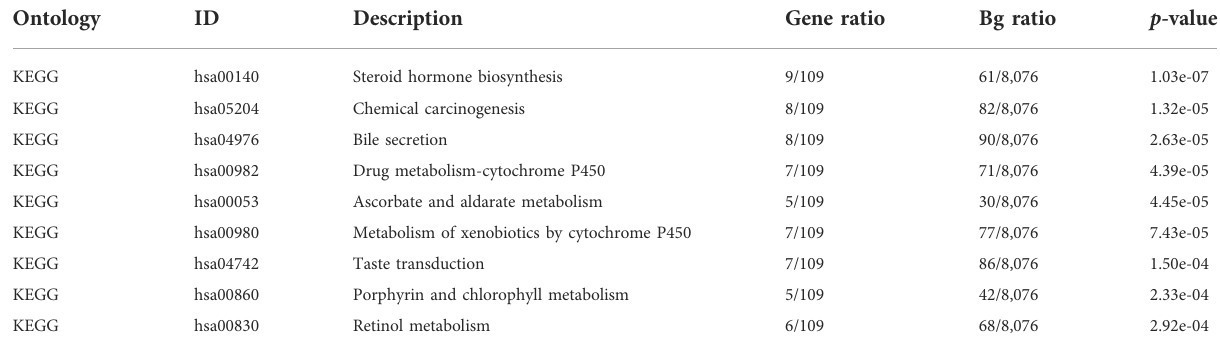
TABLE 2 KEGG enrichment analysis.